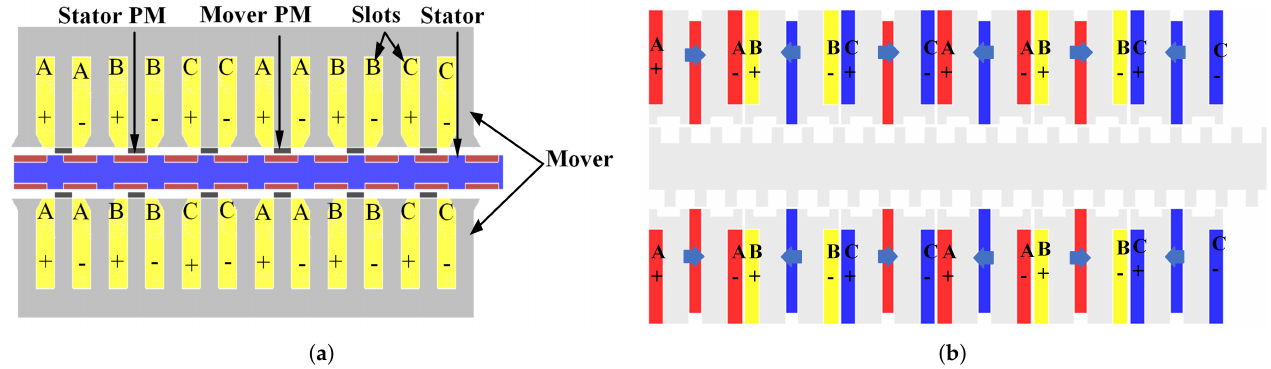
Figure 1. Nominal case: ( a ) Conventional dual permanent magnet (PM) machine for ropeless elevator applications. ( b ) Proposed dual mover yokeless multi-tooth PMFSM for ropeless elevator applications.